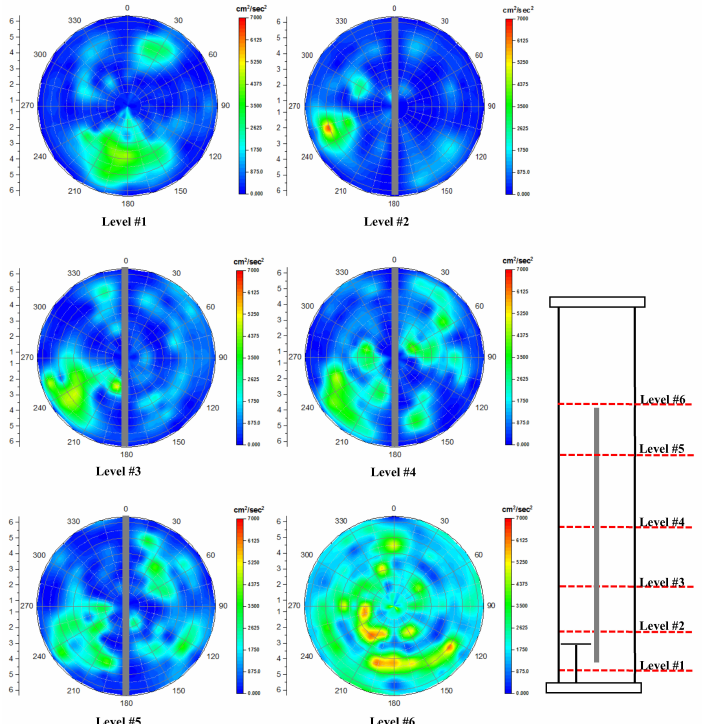
Figure 18. Cross-sectional distributions of shear stress at different heights of split airlift reactor operated under gas velocity of 3